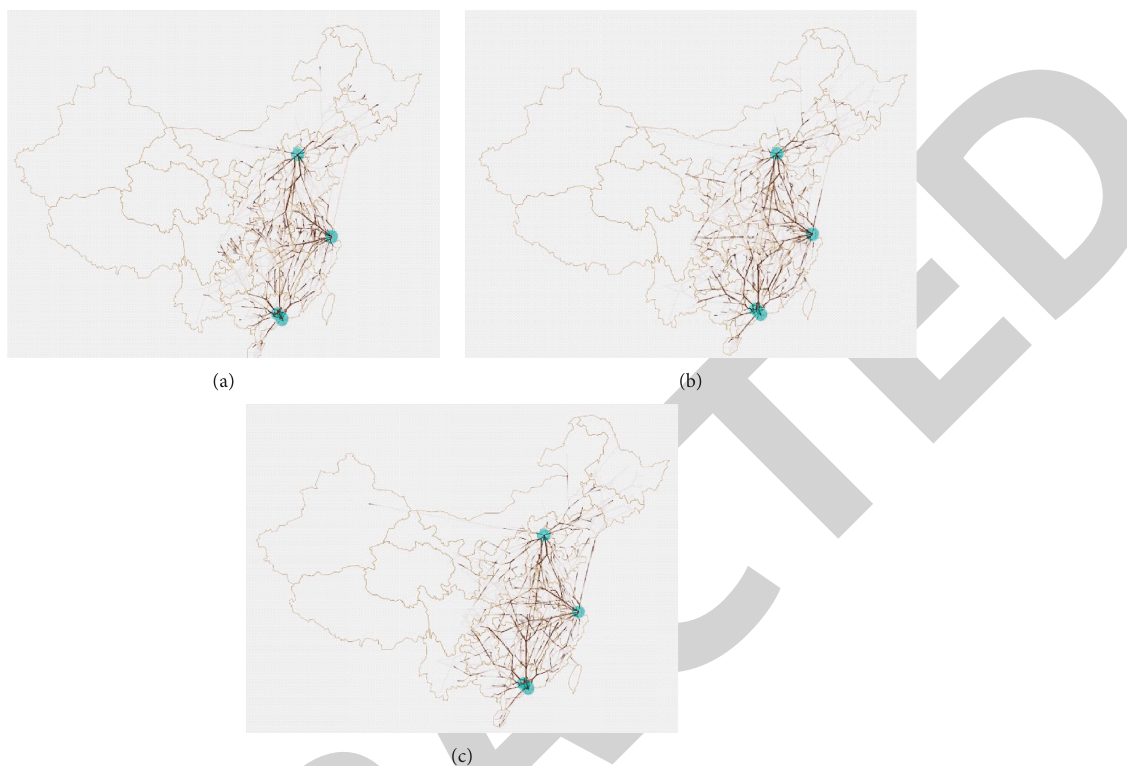
Figure 9: Time series of air traffic flow management of civil aviation based on spatial data model. (a) Time 1. (b) Time 2. (c) Time 3.